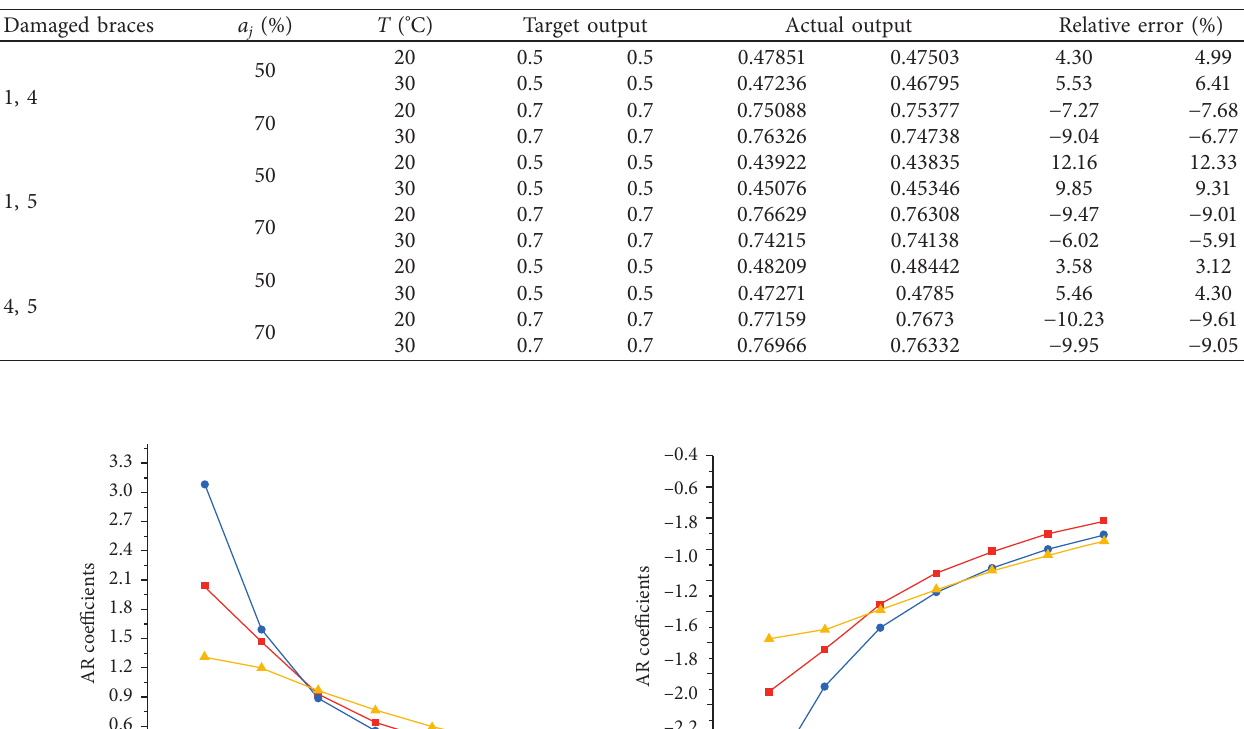
The target results of networks are shown in the Table 7: The identification results of damage severities when two braces are damaged.